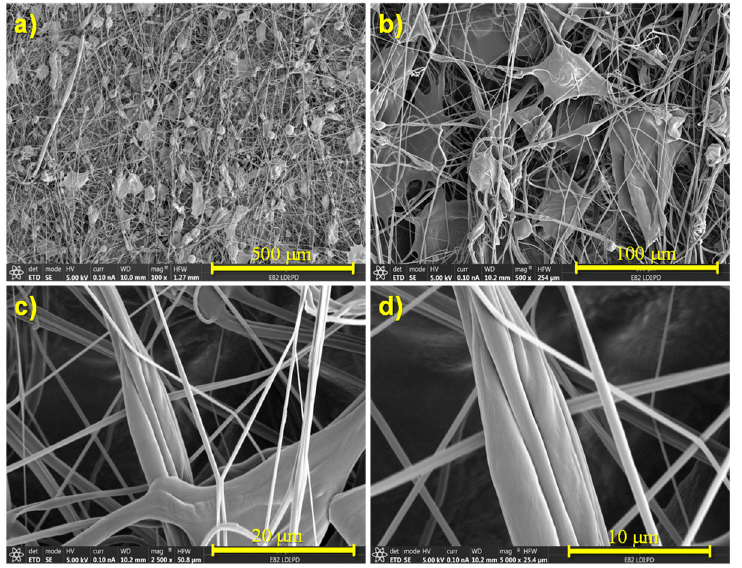
Figure 2. SEM images of the SBS neat TPU, sample without MWCNT, at different magnifications: ( a ) 100 × ; ( b ) 500 × ; ( c ) 2500 × ; ( d ) 5000 × .